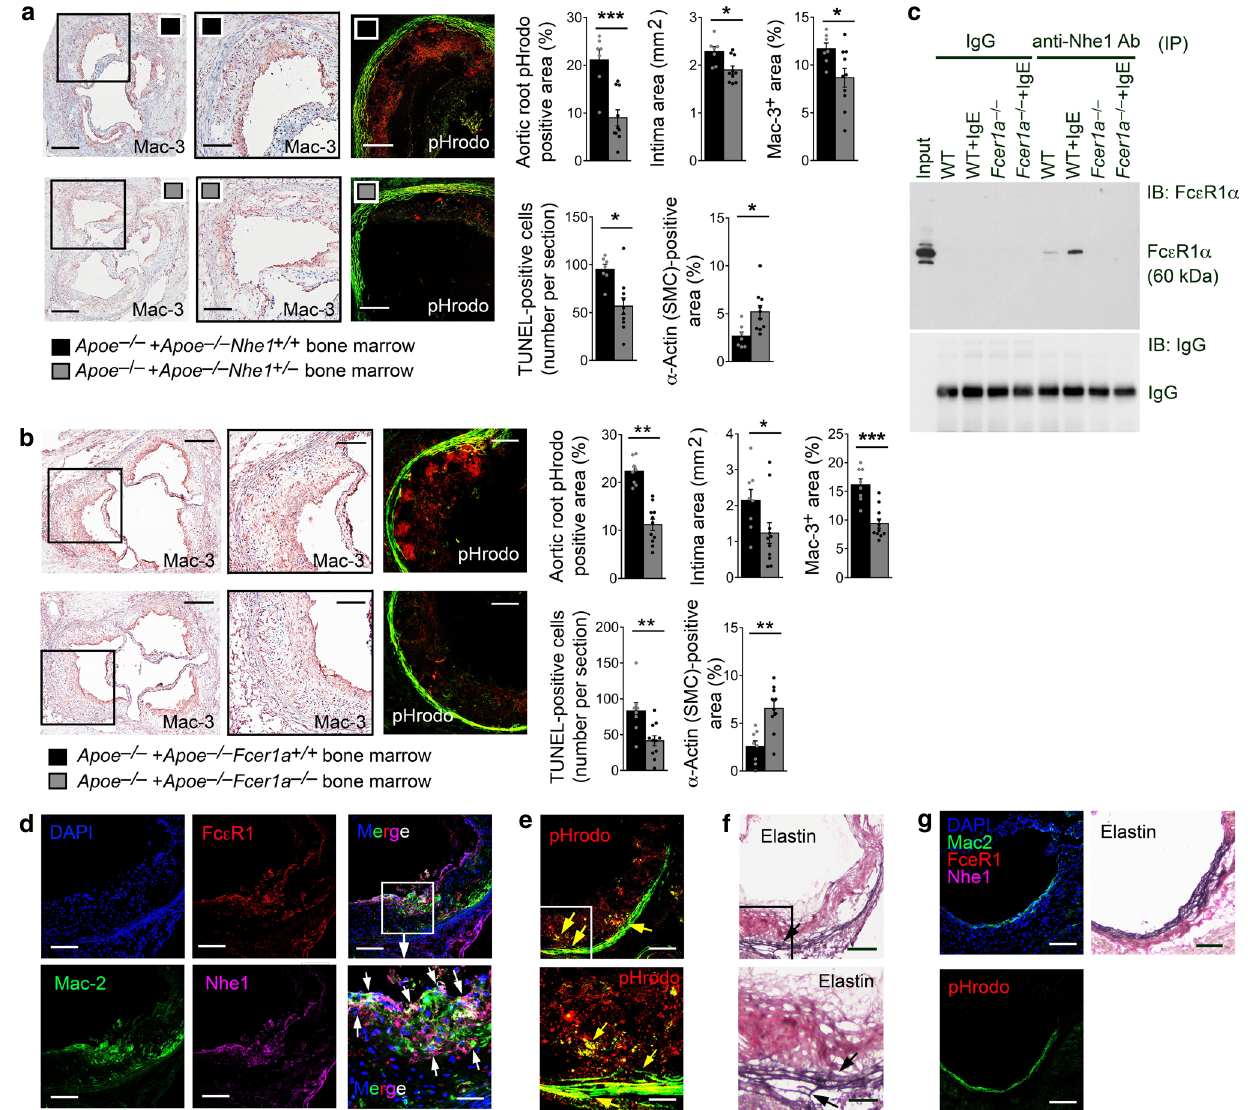
Fig. 4 Role of macrophage Nhe1 in atherosclerosis. Quanti fi cation of aortic root pHrodo-positive area, intima area, Mac-3 + macrophage content, TUNEL- positive apoptotic cell number, and α -actin-positive SMC content in Apoe – / – mice received bone-marrow from Apoe – / – Nhe1 + / + ( n = 7) and Apoe – / – Nhe1 + / – ( n = 10) donor mice a or received bone-marrow from Apoe – / – Fcer1a + / + ( n = 8) and Apoe – / – Fcer1a – / – ( n = 11) donor mice b as indicated. Representative images of macrophage staining and pHrodo detection for panels a and b are shown to the left. Bars: 500 µ m, inset bars: 200 µ m. Data are mean ± SEM. Mann – Whitney U- test (intima area in b ) and two-tailed Student ’ s t test (all other panels) were used for statistic analyses. * P < 0.05; ** P < 0.01; *** P < 0.001. Source data are provided as a Source Data fi le. c Immunoprecipitation (IP) and immunoblot (IB) analysis of macrophages from WT and Fcer1a – / – mice after cells are treated with or without IgE. Cell lysate IP is performed using anti-Nhe1 antibody and IB is performed using either anti-Fc ε R1 antibody (top panel) or directly with HRP-conjugated anti-IgG antibody (bottom panel). Input cell lysate from IgE-treated WT macrophages is used as positive control. d Immuno fl uorescent triple staining for Mac-2 macrophages, Fc ε R1, and Nhe1 in atherosclerotic lesions from Apoe – / – Nhe1 + / + mice ( n = 9). White arrows indicate Fc ε R1 and Nhe1 colocalization on Mac-2 + macrophages. Parallel sections of panel d are stained for pHrodo e and elastin f . Yellow and black arrows indicate elastin breaks. g Immuno fl uorescent triple staining for Mac-2, Fc ε R1, and Nhe1 in aortic root section from healthy WT mice ( n = 4) as negative control. Parallel sections are stained for pHrodo and elastin. Bars in d – g : 200 µ m, inset bars in d – f : 70 µ m. Source data are provided as a